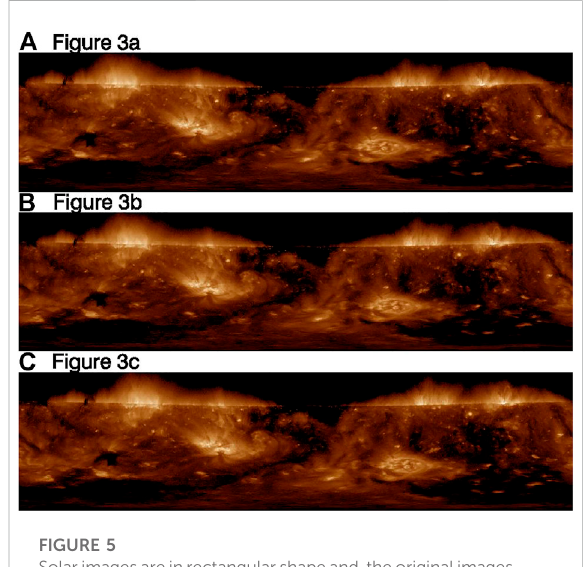
FIGURE 5 Solarimagesareinrectangularshapeand,theoriginalimages are in Figure 3A, Figure 3B, and Figure 3C.